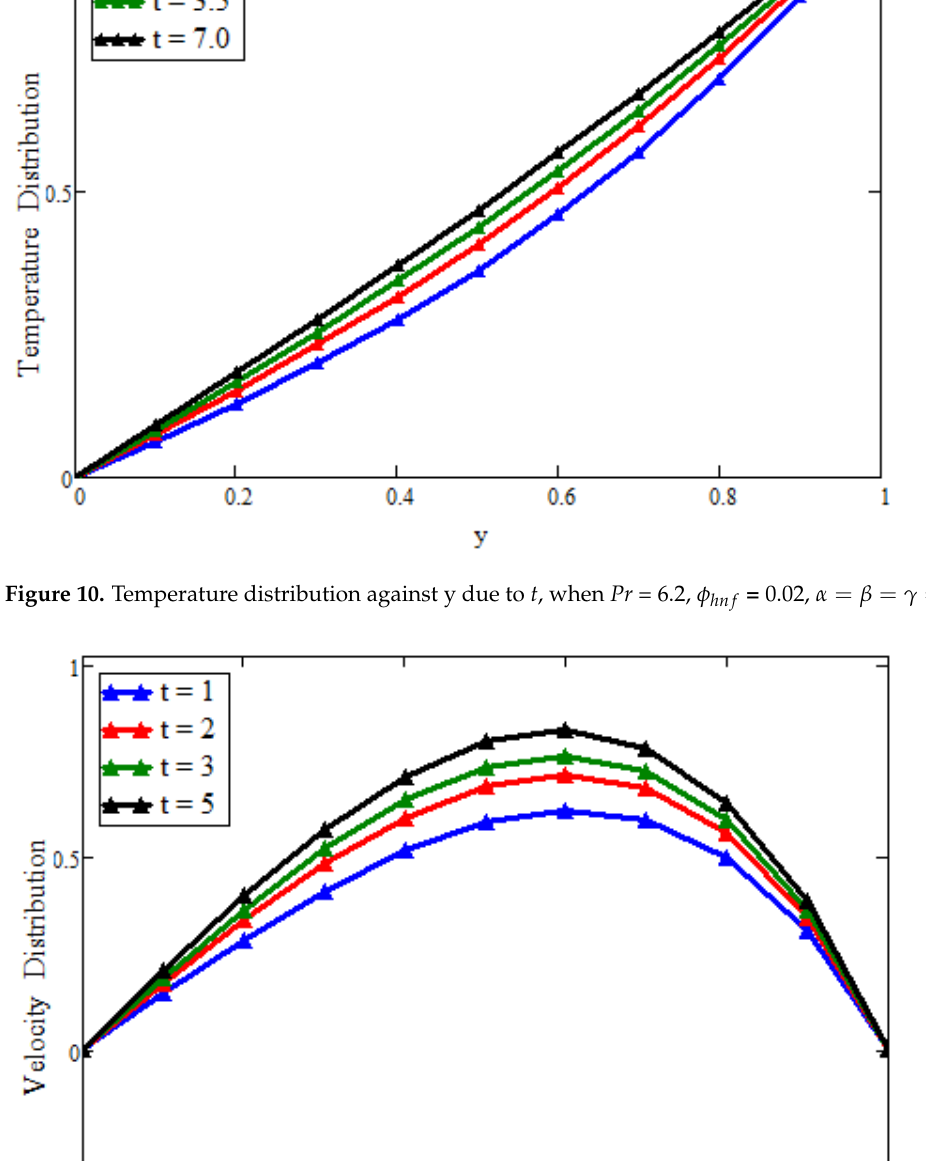
Figure 11. Velocity distribution against y due to t , when Pr = 6.2, φ hnf = 0.04, Gr = 15, M = 0.1, 𝛼 = 𝛽 = 𝛾 = 0.5 .